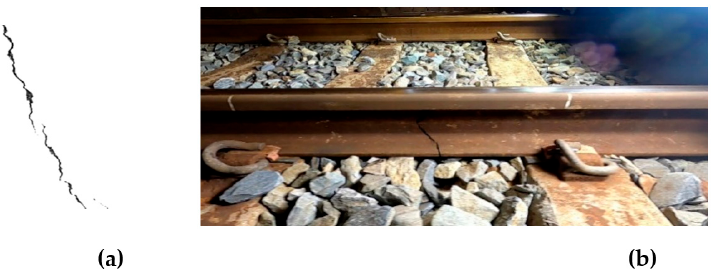
Figure 7. Human synthesized images. ( a ) crack image; ( b ) human ‐ made images.